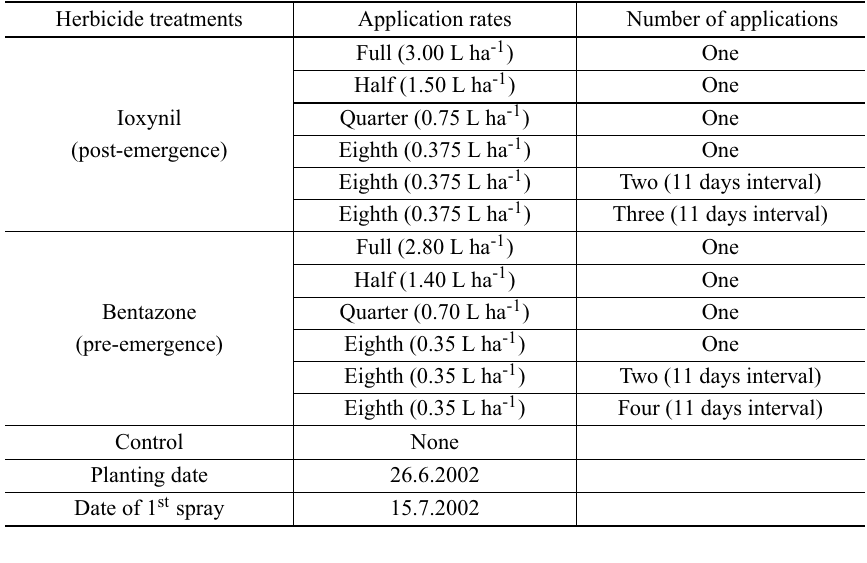
Herbicide treatments for onion.